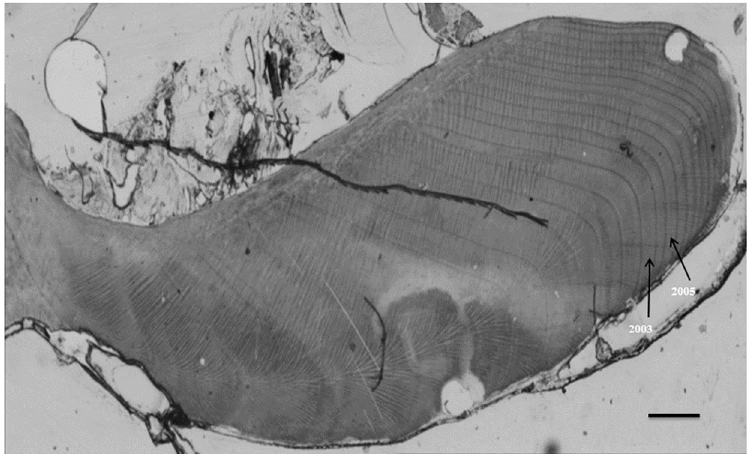
Fig 2. A digital photomosaic of an acetatepeel replica of growth increments in the G . glycymeris hinge. Black scale bar is 500 μ m.Black arrows indicate marker years where there was increasedgrowth. Shell ID: 14101004,collectedin October